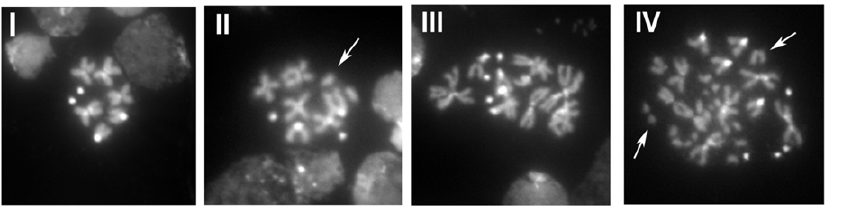
Figure 2. Slbp mutants have increased DNA damage and exhibit tetraploid nuclei. Larval neuroblast karyotypes were obtained for Slbp 15 and w 1118 3 rd instar larvae. Each karyotype was assigned to one of four categories: I) Normal karyotype with no chromosomal breaks II) Normal karyotype with at least one chromosomal break (arrow), III) Tetraploid with no breaks, IV) Tetraploid with at least one break (arrows). White arrows indicate examples of chromosomal breaks.